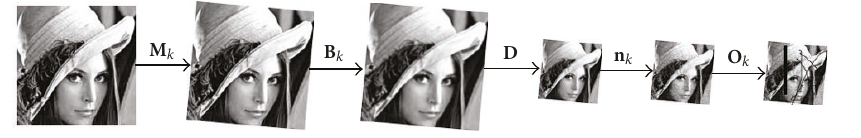
Figure 2: Block diagram illustration of the observation model (2), where the far left is the desired high-resolution image, and the far right is the observed